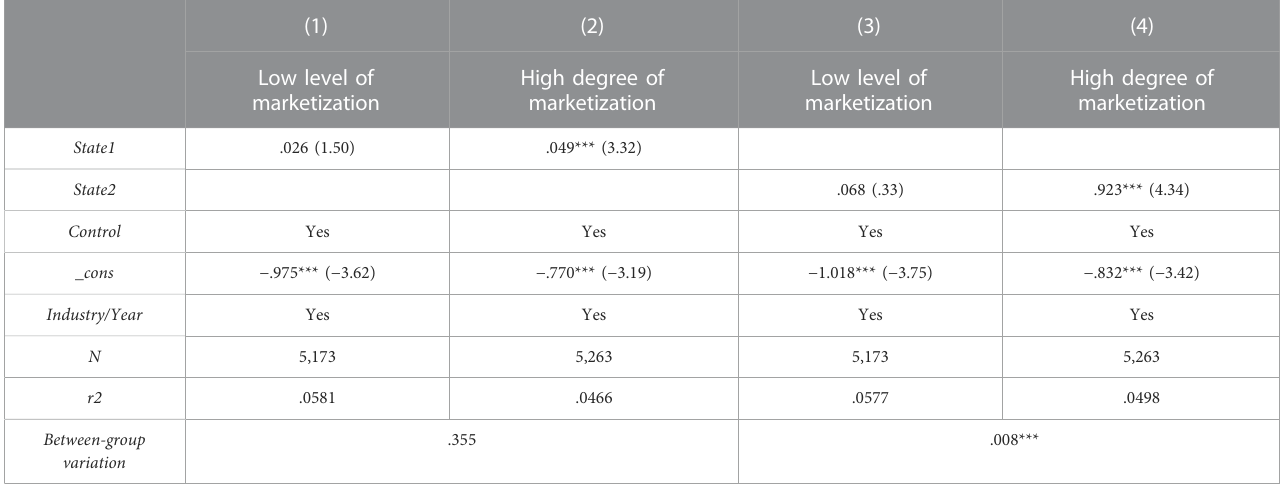
TABLE 6 Group test of the degree of marketization of the region in which private enterprises are located.